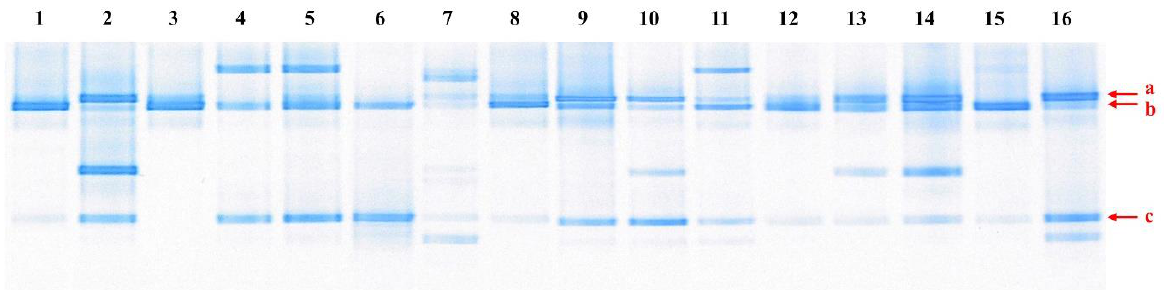
Figure 1. PCR-DGGE patterns of 16S rRNA gene fragments from kimchi samples. 1~16: Kimchi samples 1~16. The closest relatives of the fragments (arrowed) were determined and compared with sequences in GenBank.